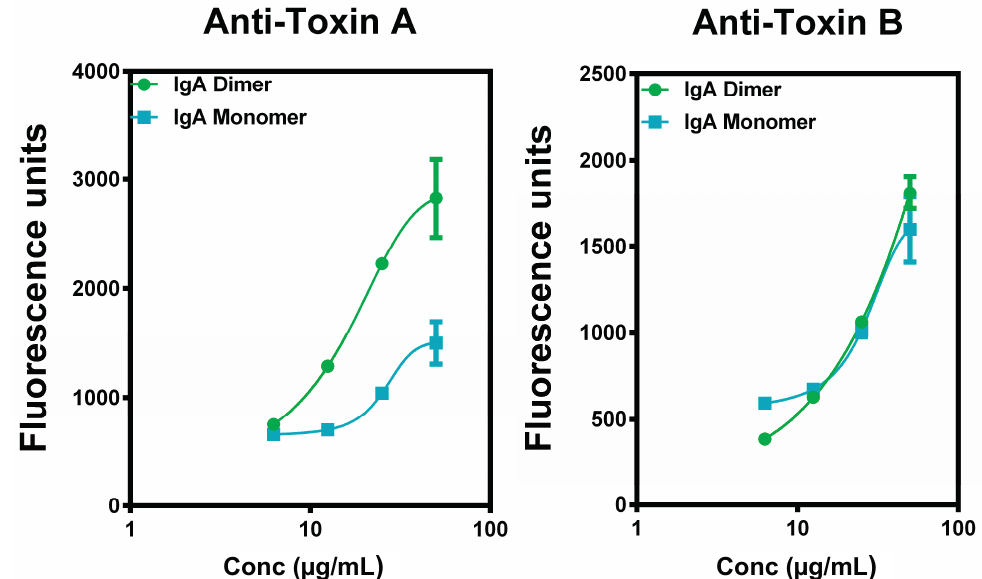
Figure 5. Figure 5 demonstrates that both dimeric and monomeric IgA bind both to CdtA and CdtB. There is more binding to CdtA by dimeric IgA than by monomeric IgA. There is similar binding to CdtB by dimers and monomers.